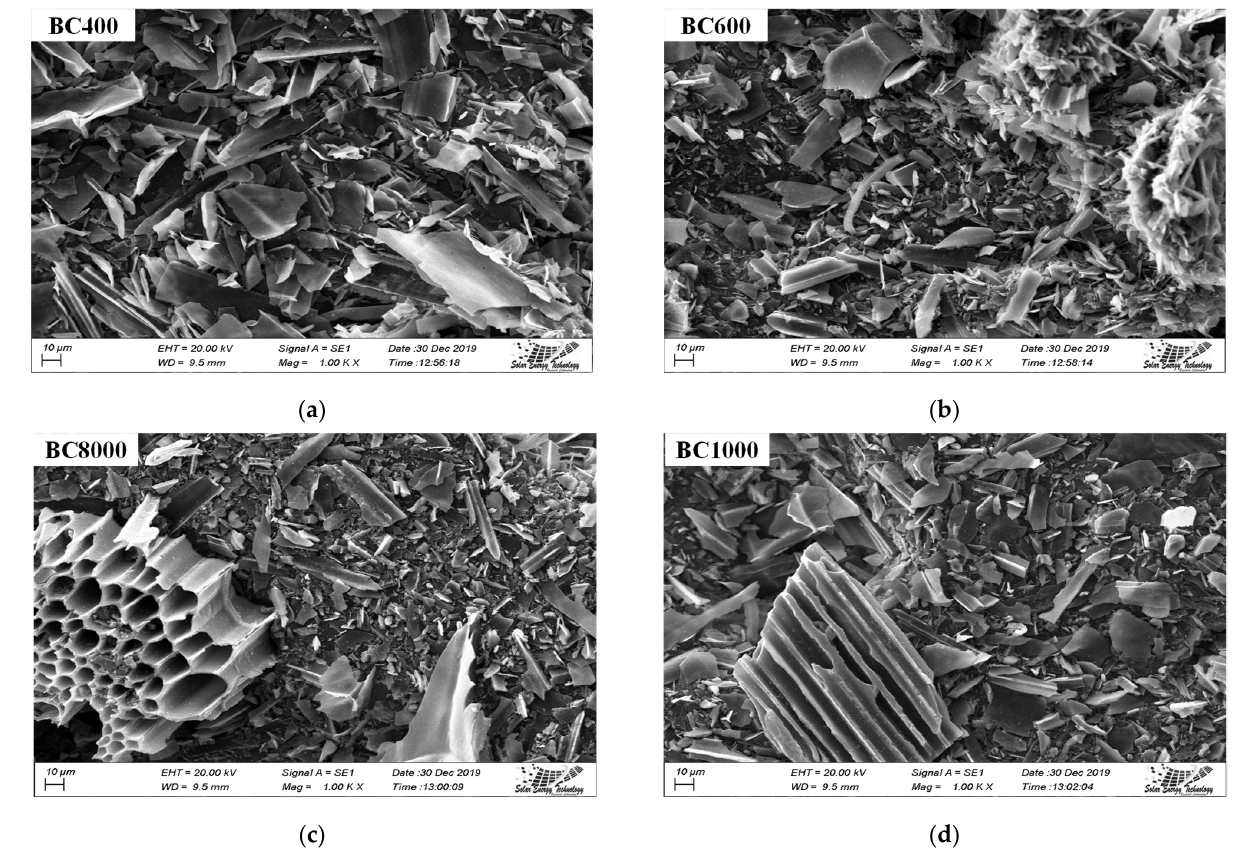
Figure 3. SEM images of biochar produced at different pyrolyzing temperatures ( a ) 400 °C ( b ) 600 °C ( c ) 800 °C and ( d ) 1000 °C.